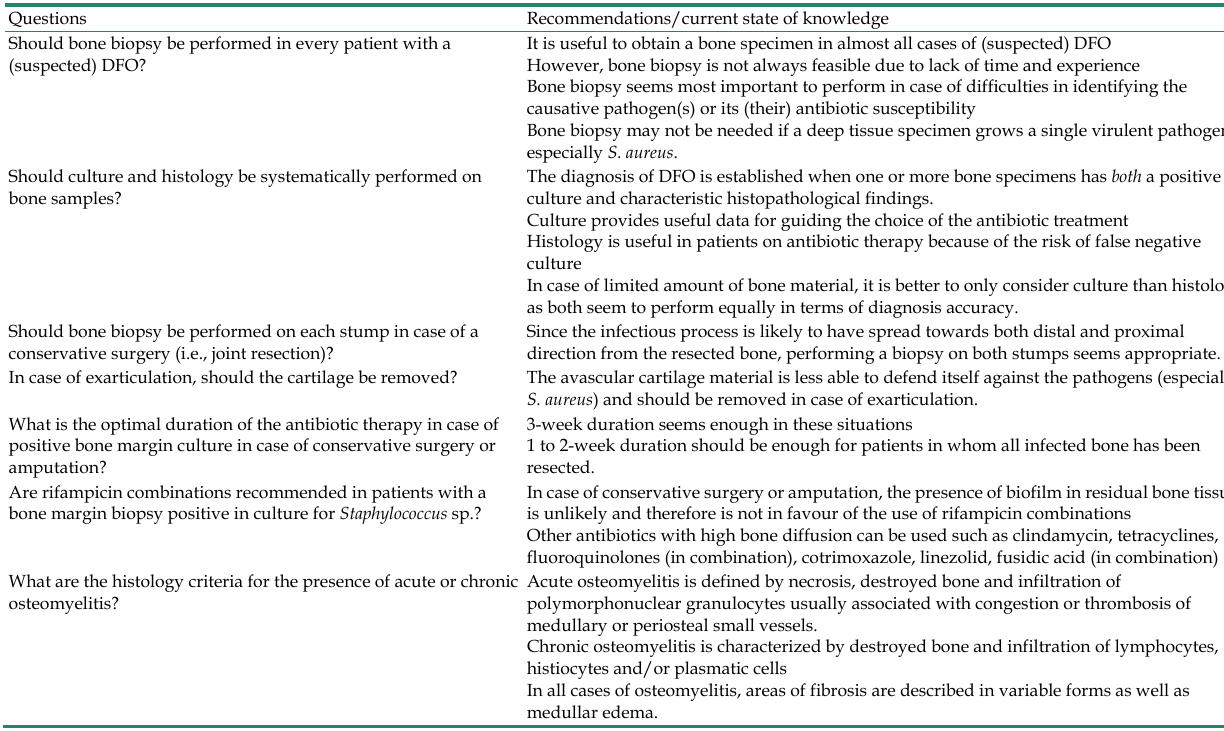
Table 1. Recommendation/current state of knowledge regarding surgical bone biopsy in patients with diabetic foot osteomyelitis